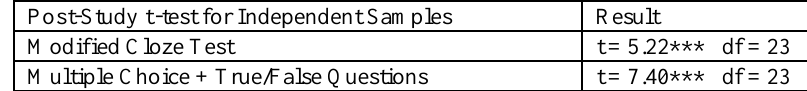
Table 4.11 Reading Comprehension